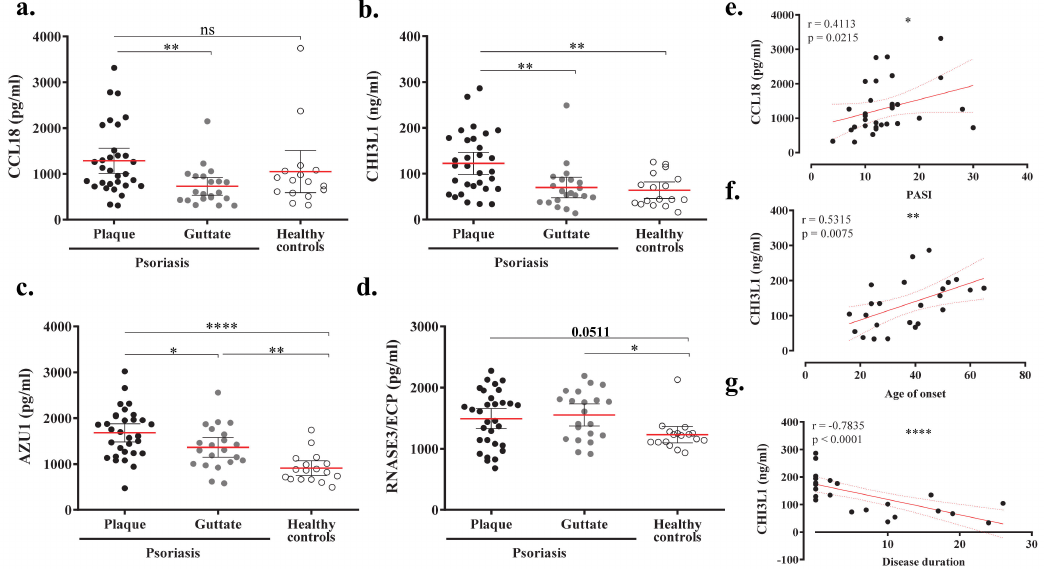
Figure 3. AZU1, CCL18, CHI3L1 and AZU1 are significantly increased in plasma from plaque psoriasis compared to guttate or/and healthy controls. CCL18, CHI3L1, AZU1 and RNASE3/ECP levels were assessed by ELISA in plasmas from plaque psoriasis ( n = 31, • ), guttate psoriasis ( n = 21, • ) and healthy individuals ( n = 16, ). ( a – d ) Comparison of levels detected between (cid:35) plaque and guttate psoriasis versus controls. In plaque psoriasis patients, relevant correlations between ( e ) CCL18 and disease severity (PASI), as well as CHI3L1 and age of onset ( f ) or disease duration ( g ), were found. A Wilcoxon test was used to compare two conditions within psoriasis or controls. Spearman test was used for correlations. Spearman coefficient (r) and p values ( p ) are indicated as ns: p > 0.05; *: p < 0.05; **: p < 0.01; ****: p <